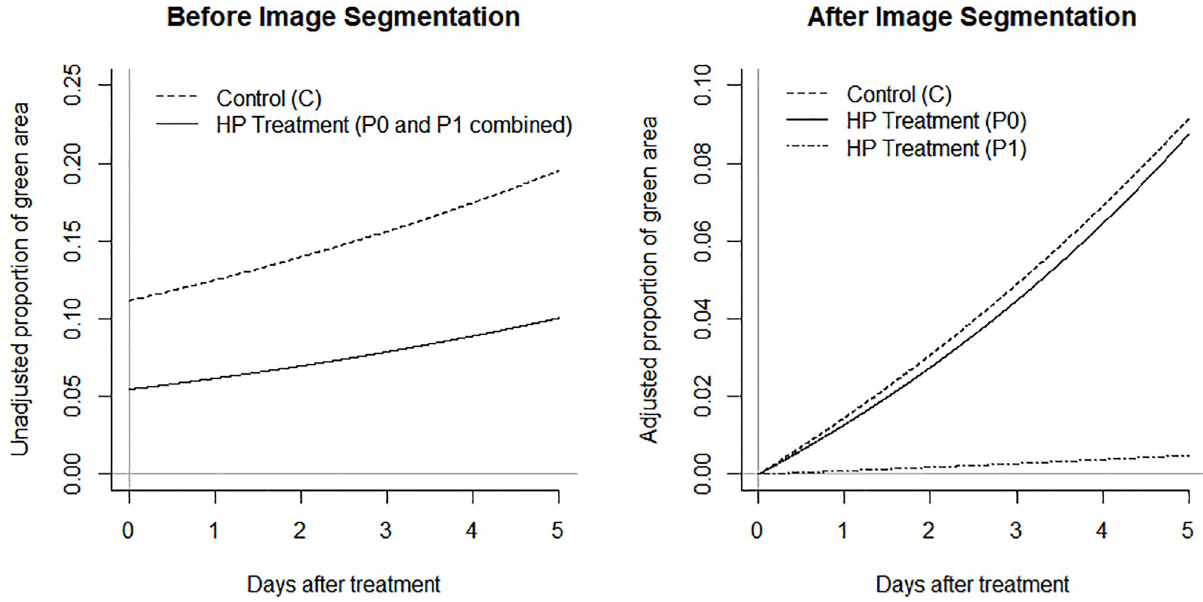
Fig 5. The unadjusted proportion of green area before the image segmentation (left panel) and the adjusted proportion of green area by using the regression parameters estimated under the beta